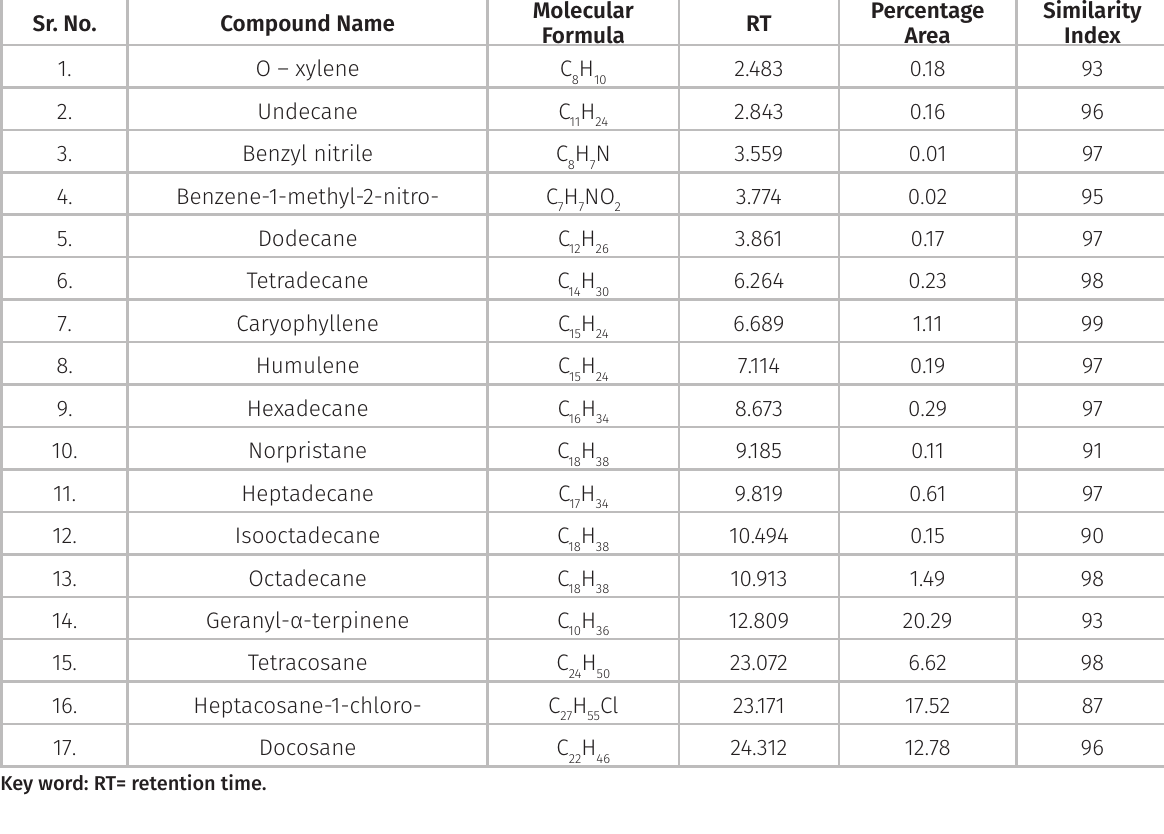
GC-MS chromatogram of n -Hexane extract from inflorescence of